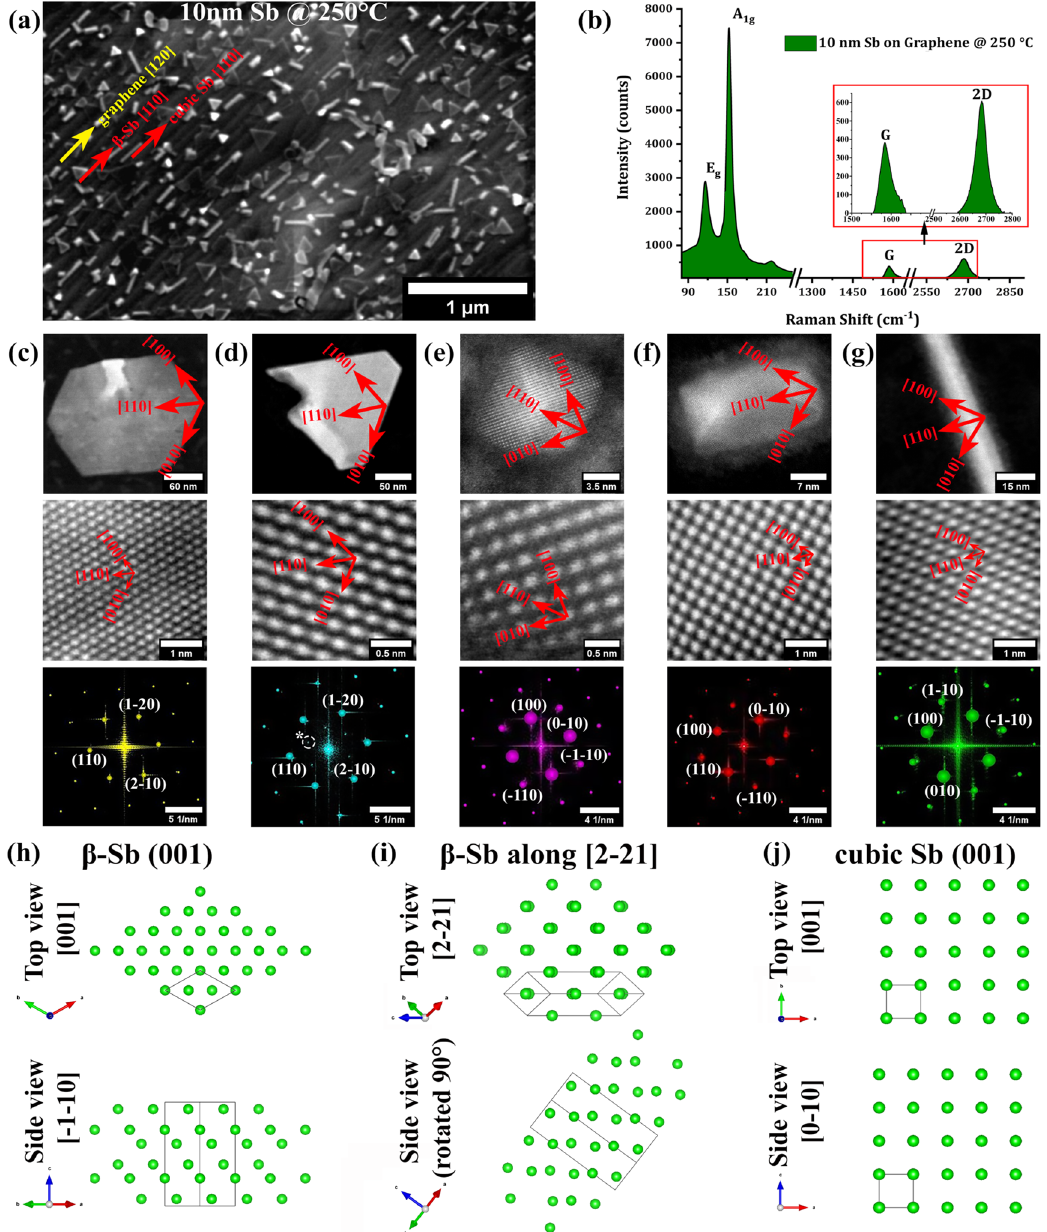
Fig. 1 Morphology and structure. a SEM image and b Raman spectrum of 10 nm Sb deposited at 250 °C onto Cu-supported CVD graphene. Salient lattice directions in the graphene and the Sb are labeled in a , as identi fi ed in the main text. c – g ADF STEM images of individual particles of 10 nm Sb deposited at 150 and 250 °C onto suspended monolayer graphene, showing overview (top) and atomic resolution images (middle) and corresponding FTs (bottom). The FTs are indexed to β -Sb(001) viewed along [001] zone axis ( c , d ) and cubic Sb(001) viewed along [001] zone axis ( e – g ), respectively. Corresponding salient crystallographic directions are superimposed over the ADF images. The sixfold symmetric “ * ” -indexed re fl ection set in d is ascribed cubic Sb 2 O 3 viewed along the [111] zone axis and corresponds to Sb 2 O 3 (2-20) re fl ection family, as described below. False-color coded ADF STEM images of overview and atomic resolution images can be found in Supplementary Fig. 1. h – j Atomic models of β -Sb(001), β -Sb[2-21], and cubic Sb(001), respectively. For further information on atomic models and FT simulations see Supplementary Figs. 2 and